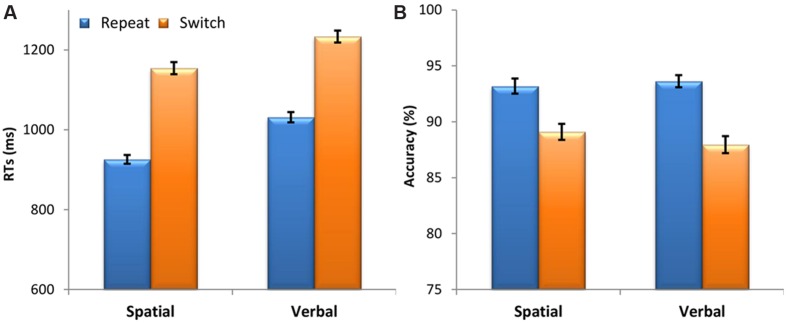
Behavioral results.
(A) Mean response times (RTs) in milliseconds (ms) and (B) accuracy (percentage of correct responses) as a function of Domain (spatial, verbal) and Switching from the previous task (repeat, switch). Vertical bars represent the within-subjects standard errors of the mean (Morey, 2008).